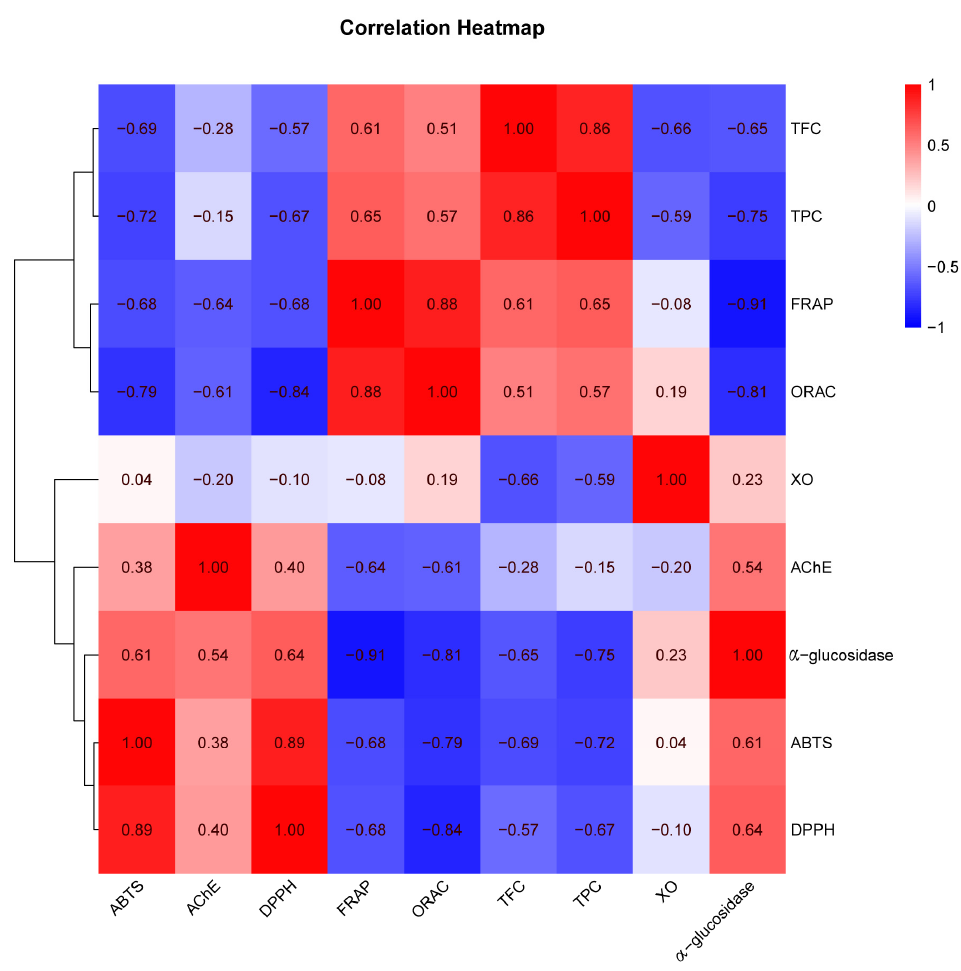
Figure 2. Heatmap graph of correlation analysis. p -value (ranging from − 1 to 1) and corresponding color (red to blue) represent the magnitude of the Pearson correlation coefficient ( r ) in the heatmap; TPC = total phenolic content; TFC = total flavonoid content; DPPH = DPPH · scavenging activity; ABTS = ABTS · + scavenging ability; FRAP = ferric reducing antioxidant power; ORAC = oxygen radical absorbance capacity; α -glucosidase = the IC 50 value for α -glucosidase inhibitory activity; AChE = the IC 50 value for acetylcholinesterase inhibitory activity; and XO = the IC 50 value for xanthine oxidase inhibitory activity. The different letters represent a significant difference, p < 0.05.